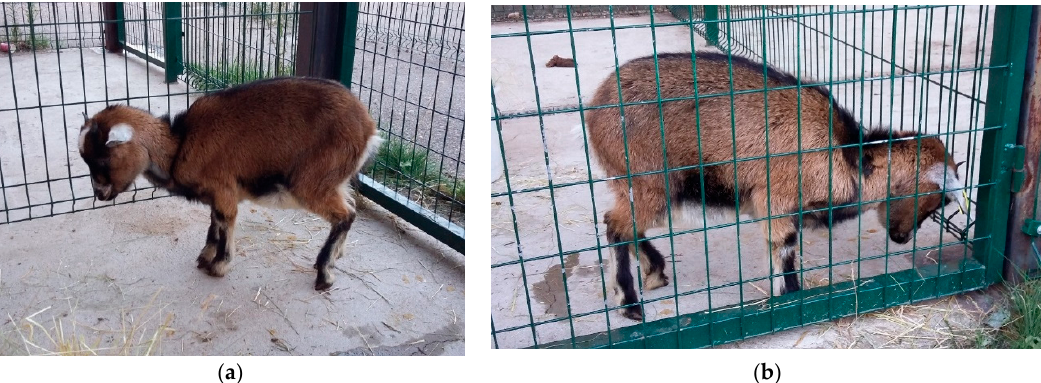
Figure 6. African pygmy goat, with hypovitaminosis B12, secondary to ruminal dysbiosis after repeated ingestion of plastics and other foreign substances (photos from Dr. González-Montaña). ( a ) Young goat, which alternated periods of intense depression with periods of normality. Sometimes with total immobility, which disappeared abruptly, ( b ) The same animal seen from the other side.